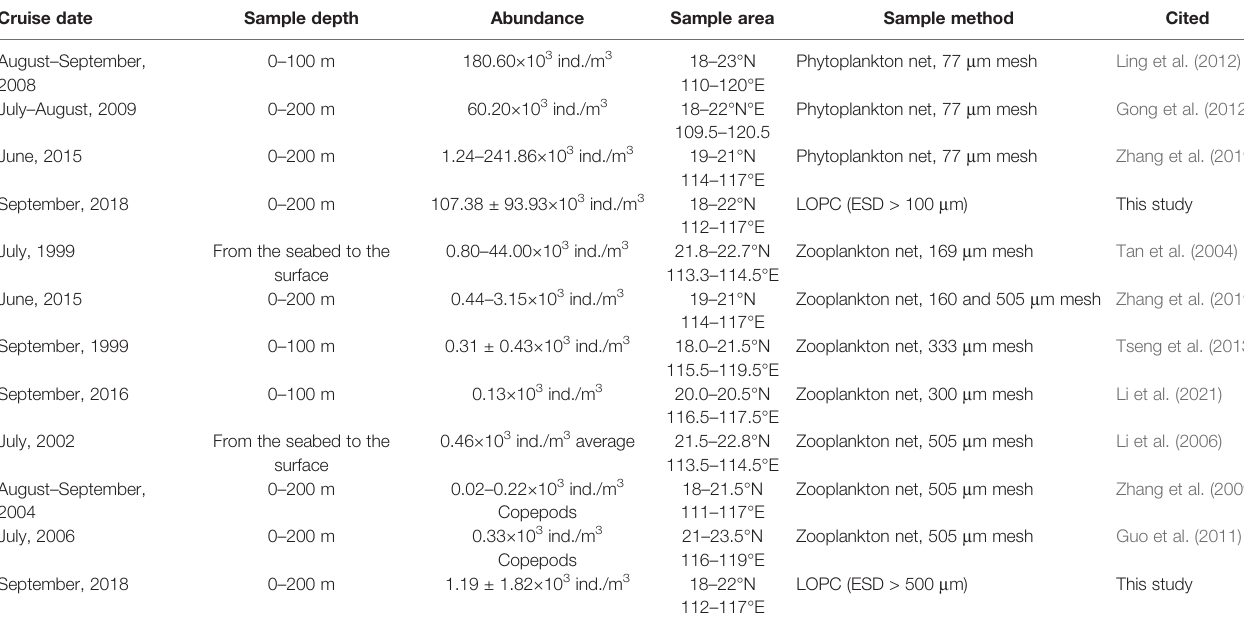
TABLE 1 | Data about plankton abundance from previous studies and this study in different size groups in the northern